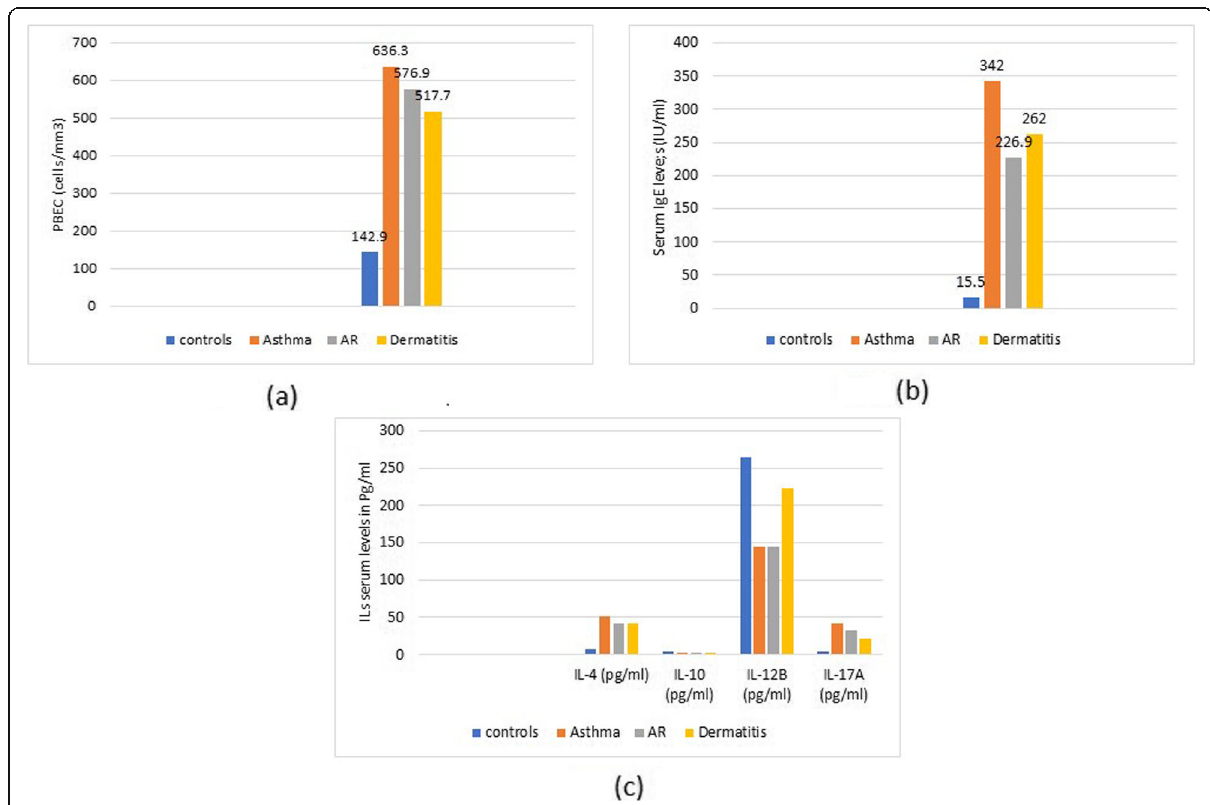
Fig. 4 a A graph comparing the total PBEC in patients ’ subgroups and controls. b A graph comparing the total IgE levels in patients ’ subgroups and controls. c A graph comparing IL4, 10, 12B, and 17A levels in patients ’ subgroups and controls. All parameters represented as mean.